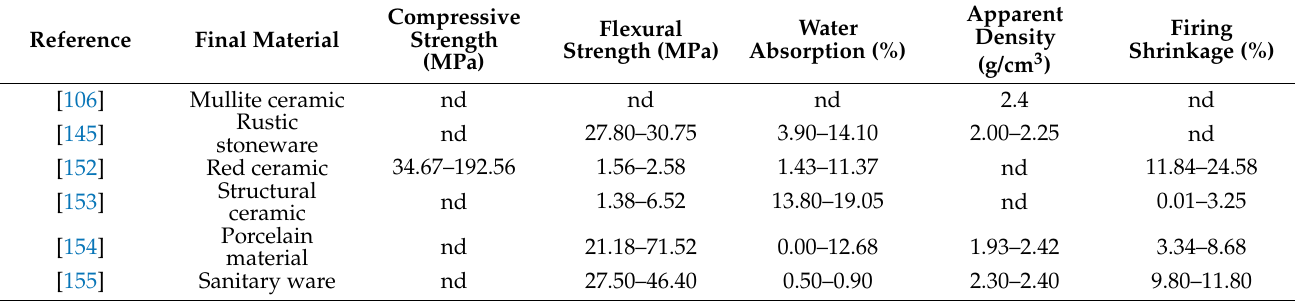
Table 25. Technological properties of mullite-based materials developed from quartz and quartzite waste.